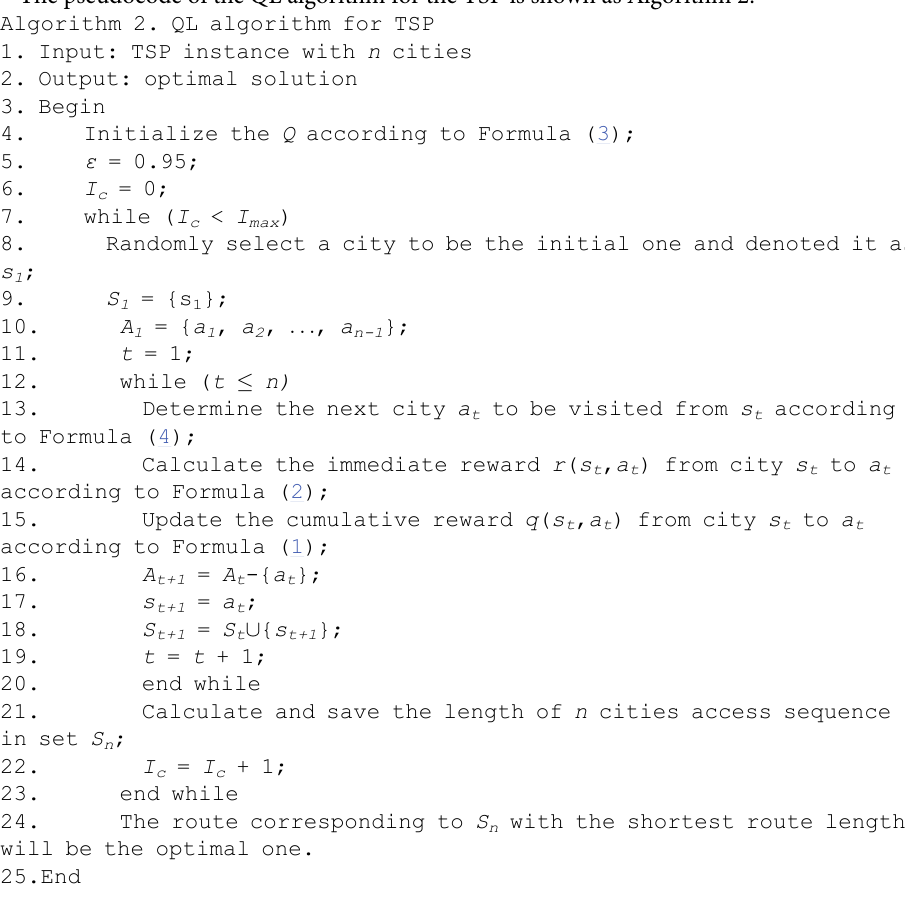
Algorithm 2. QL algorithm for